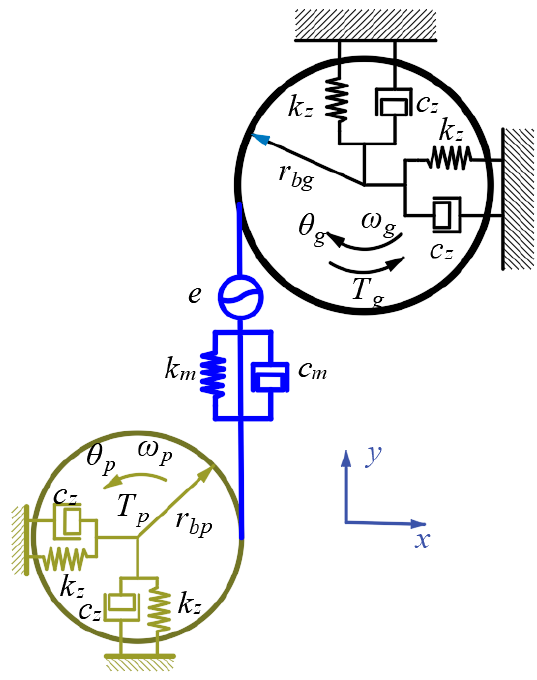
Figure 1. Tribological-dynamic model.